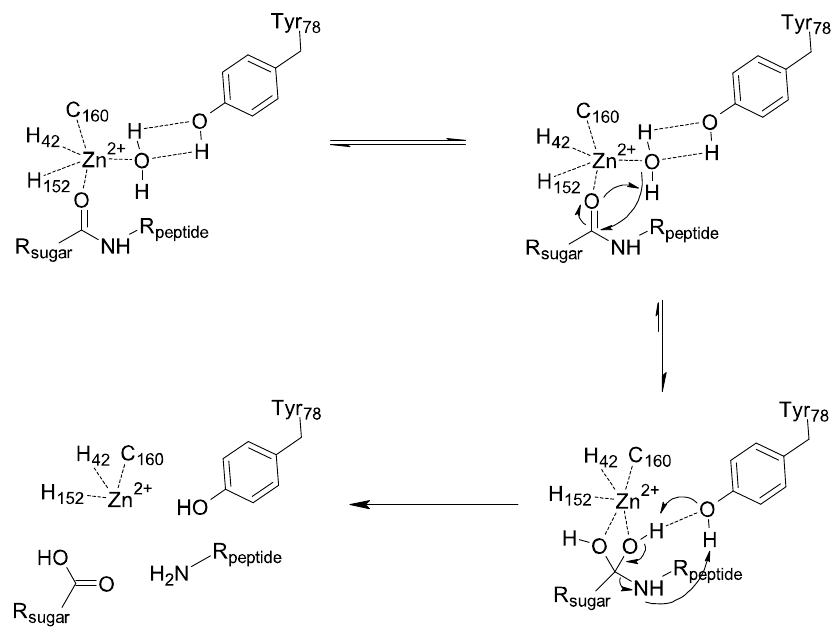
Figure 5. Proposed mechanism for Drosophila PGRP-LB.